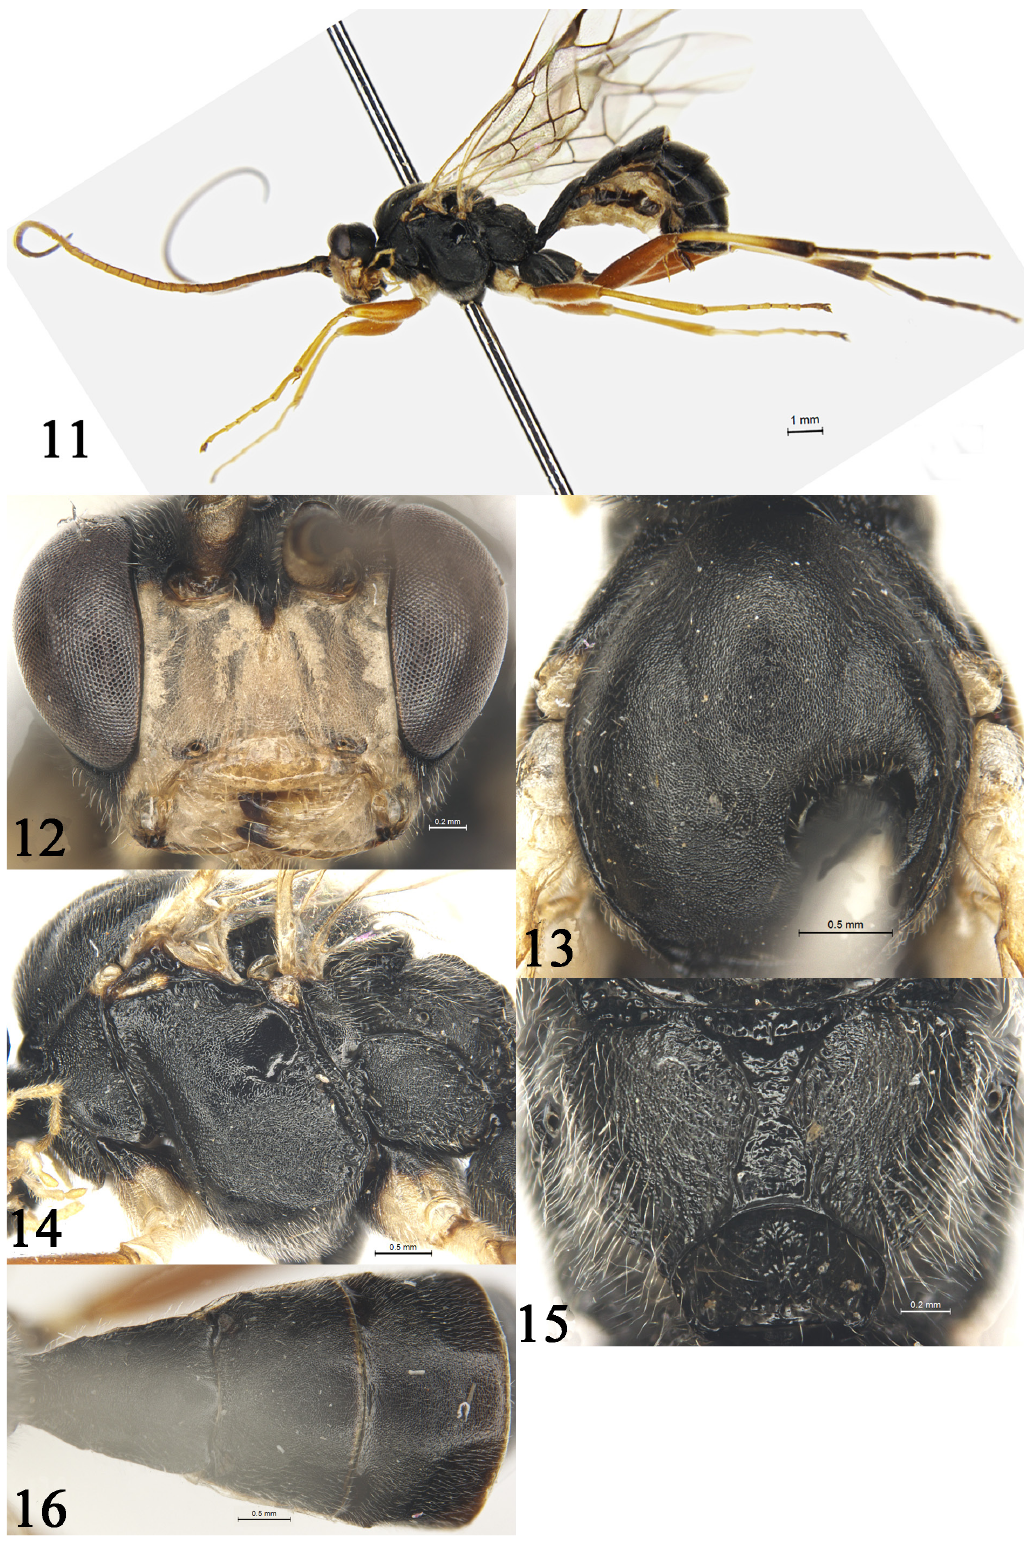
Figs 11–16. Mesoleius (? Campodorus ) faciator Kasparyan, 2001, ♀ ( GSFGPM). 11 . Habitus, lateral view. 12 . Head, anterior view. 13 . Mesoscutum. 14 . Mesosoma, lateral view. 15 . Propodeum. 16 . Tergites 1–3, dorsal